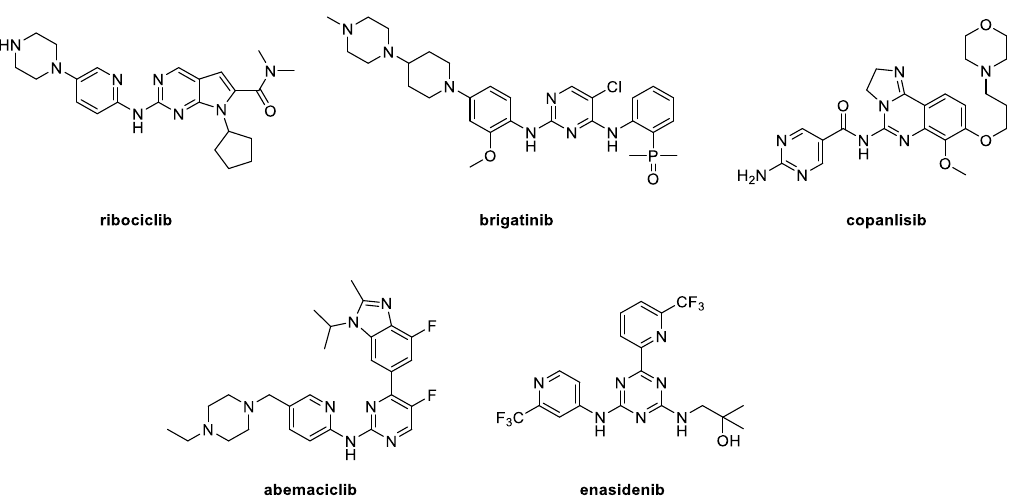
Figure 1. Chemical structures of some FDA (Food and drug administration)-approved anticancer drugs in